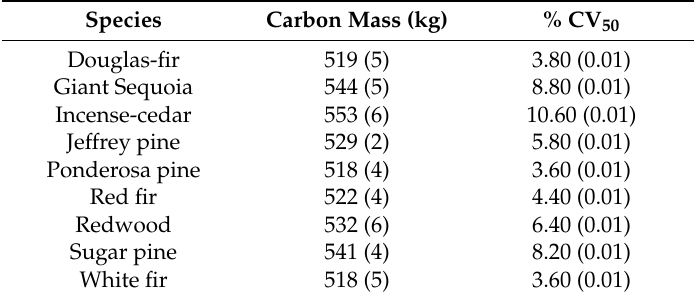
Table 3. Tree carbon masses and CV 50 values for each tree species studied based on applying measured CF values to example trees with a total biomass of 1000 kg.